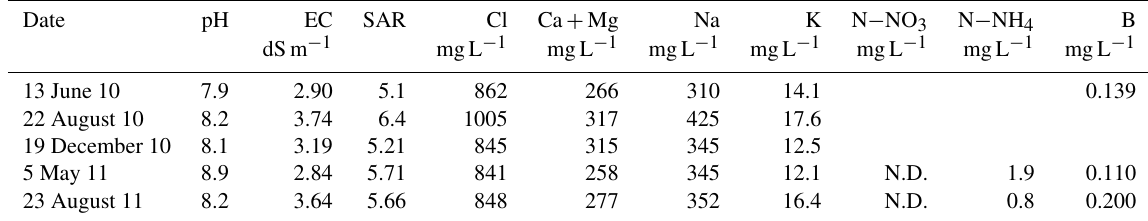
Table 1. Quality of irrigation at Kibbutz Meirav olive plantation.